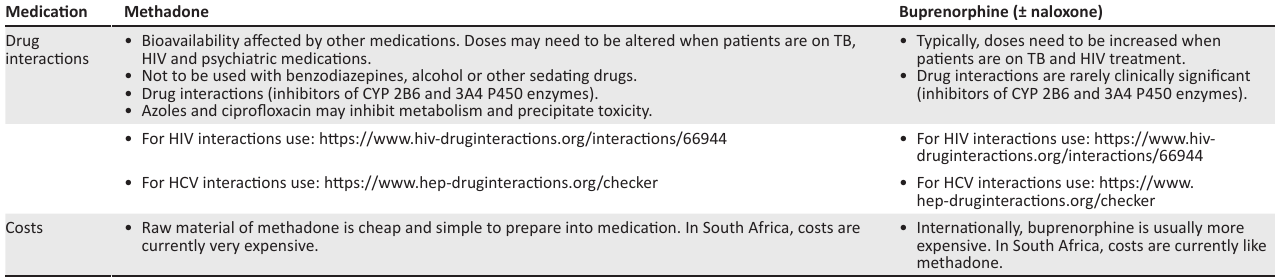
TABLE 4-A3 (Continues...): Comparison between methadone and buprenorphine (± naloxone) and clinical considerations. Medication Drug